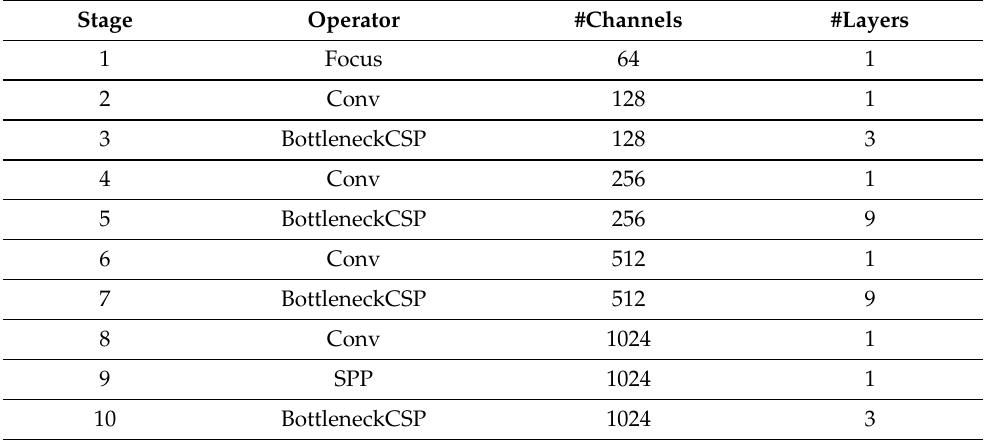
Table 1. YOLOv5 backbone